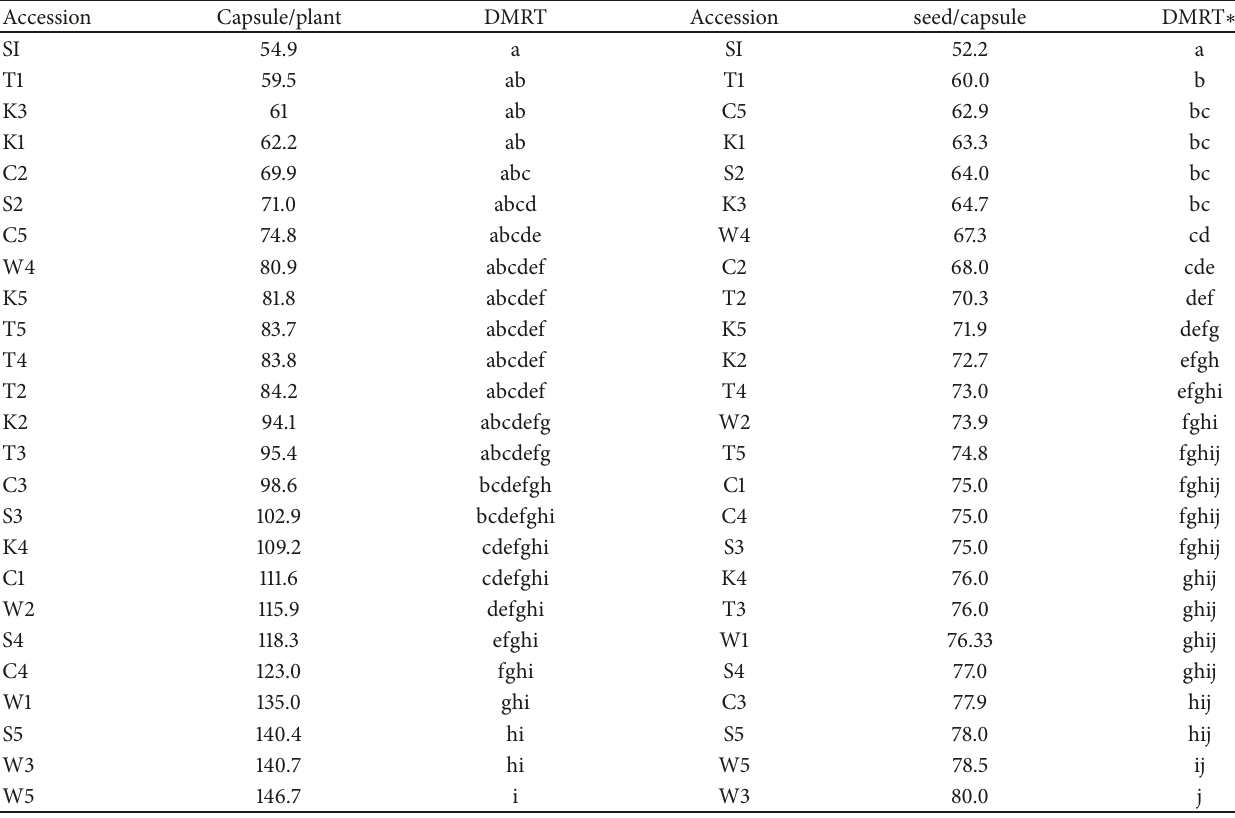
Table 3: Number of capsules per plant and seeds per